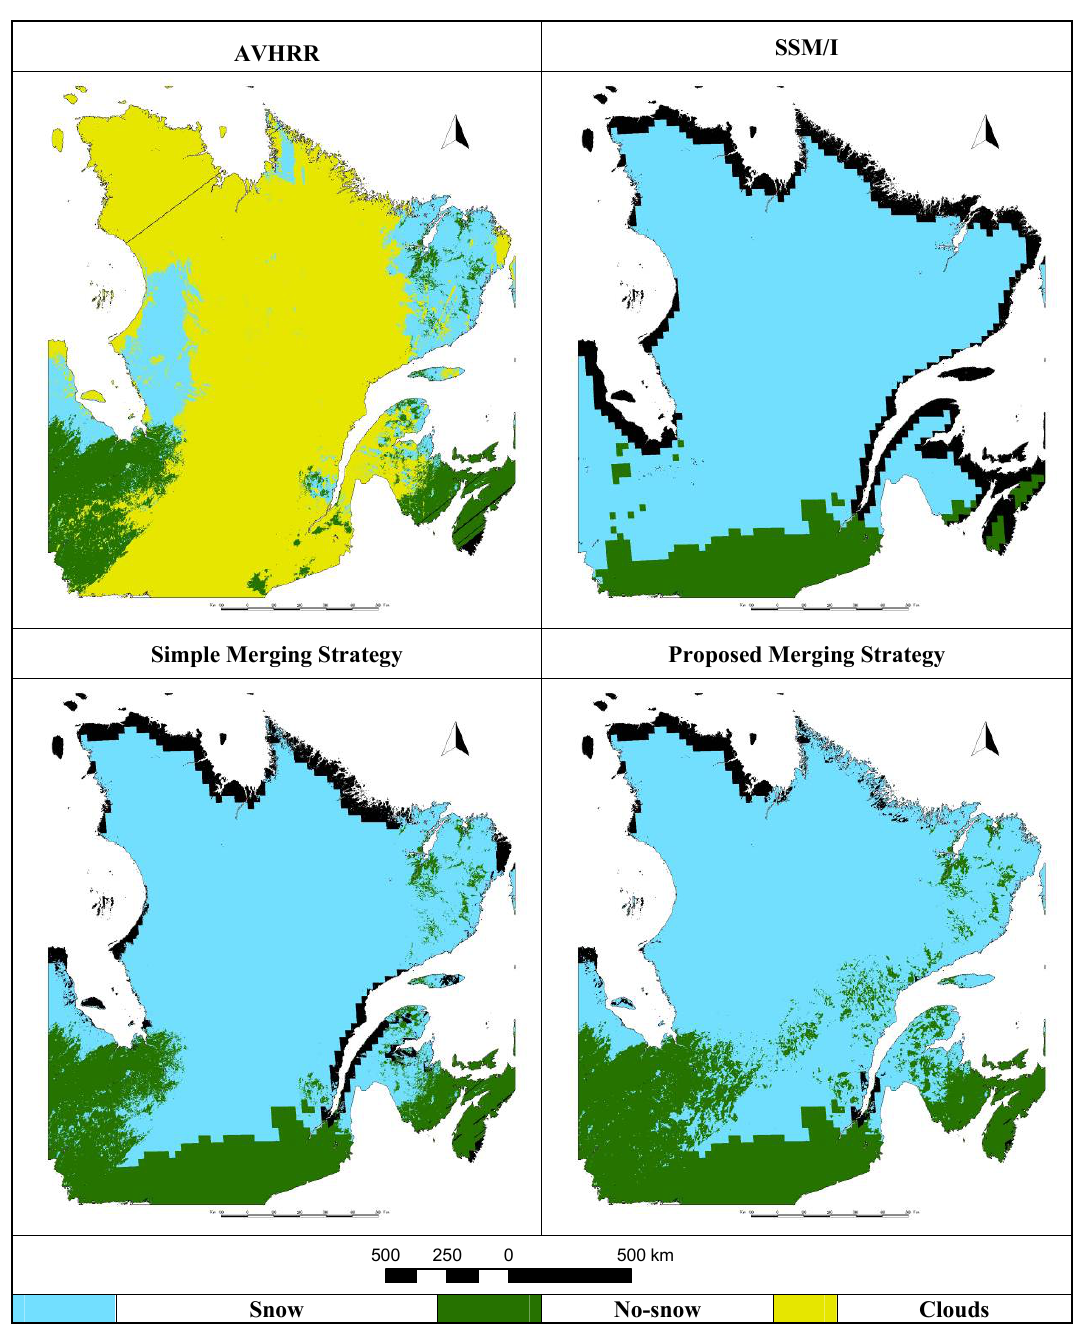
Figure 4. Snow maps for 19 April 1991 using AVHRR, SSM/I, a simple merging algorithm and the proposed merging